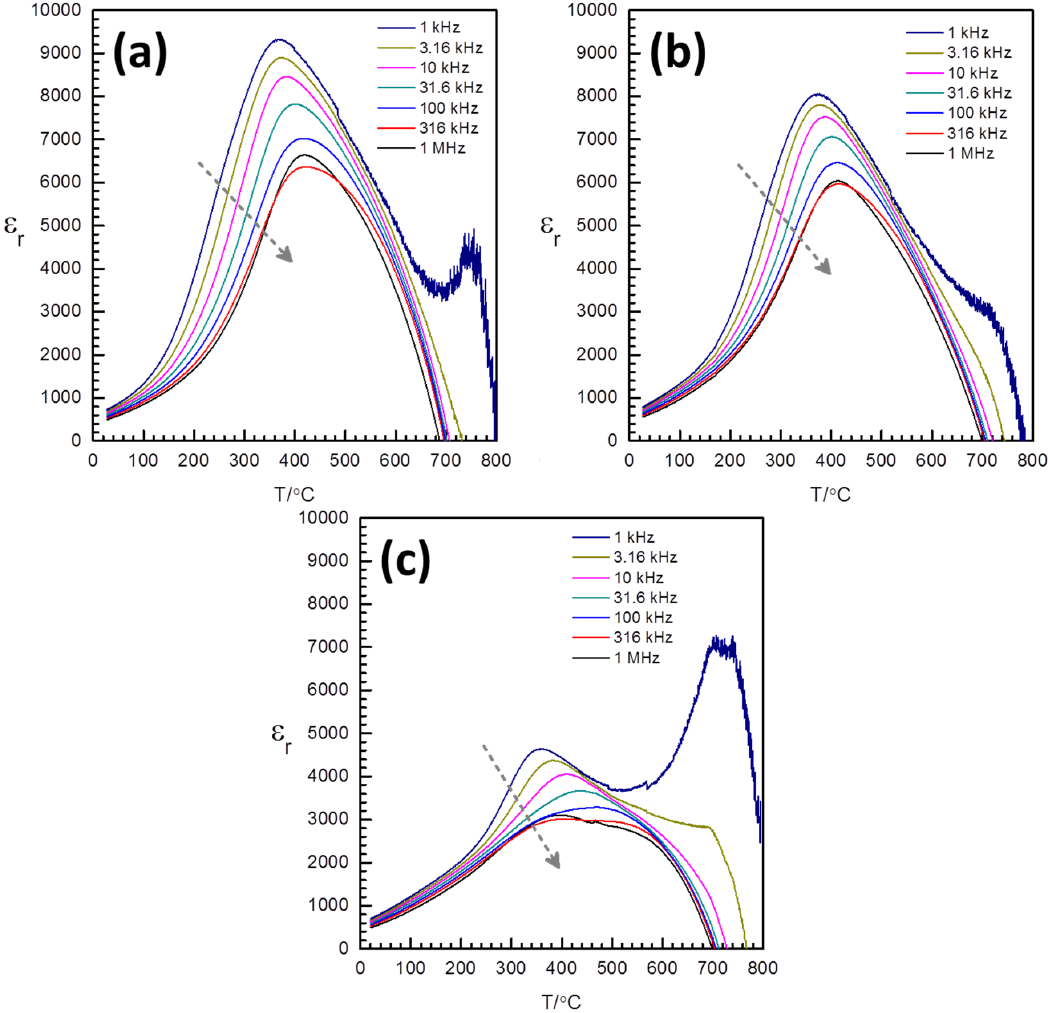
Figure 4. Relative permittivity vs. temperature for 0.4(K 0.5 Bi 0.5 )Ti (1 − x ) Nb x O 3 ‐ 0.6BiFe (1 − x ) Nb x O 3 samples sintered at 1050 °C for 1 h: ( a ) x = 0.00; ( b ) x = 0.01; and ( c ) x = 0.03.